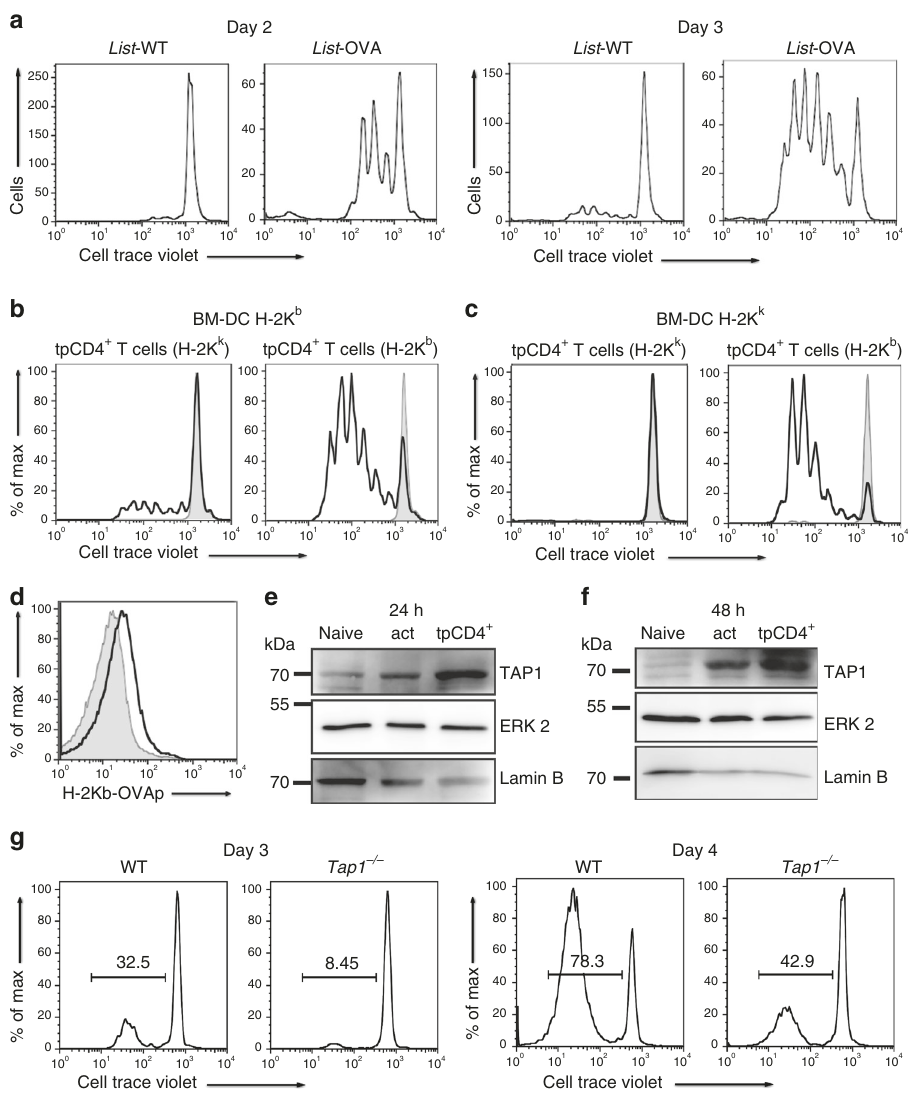
Fig. 2 tpCD4 + T cells process bacterial antigens. a Proliferation of OT-I CD8 + T cells, 2 or 3 days after incubation with Listeria-WT or Listeria-OVA tpCD4 + T cells that captured bacteria from OVAp-I-loaded BM-DC. b Proliferation of OT-I CD8 + T cells incubated with Listeria-OVA tpCD4 + T cells (H-2K k/k or H-2K k/b ), which captured bacteria from infected H-2K b BM-DC, or with Listeria-WT tpCD4 + T cells (grey). c as for b , except transphagocytosis was carried out using infected H-2K k/k BM-DC (48 h). d , H-2K b /OVA expression (detected with anti-OVAp-I/H-2K b antibody) by Listeria-OVA tpCD4 + T cells (H-2K k/b , black line; H-2K k/k , grey ) that captured bacteria from H-2K k/k BM-DC. e , f Western blot showing TAP1 expression in naive, activated ( act , by OVAp-I-loaded BM-DC) CD4 + T cells, or Listeria-OVA tpCD4 + T cells at 24 e or 48 h f after activation. ERK2 and laminB were used as protein loading controls. Note that all original western blots together with the membranes stained for molecular size markers are provided at the end of the manuscript in Supplementary Fig. 5. g Proliferation of CD8 + T cells from OT-I mice, 3 or 4 days after conjugation with Listeria-OVA tpCD4 + T cells (from Tap1 − / − or isogenic WT